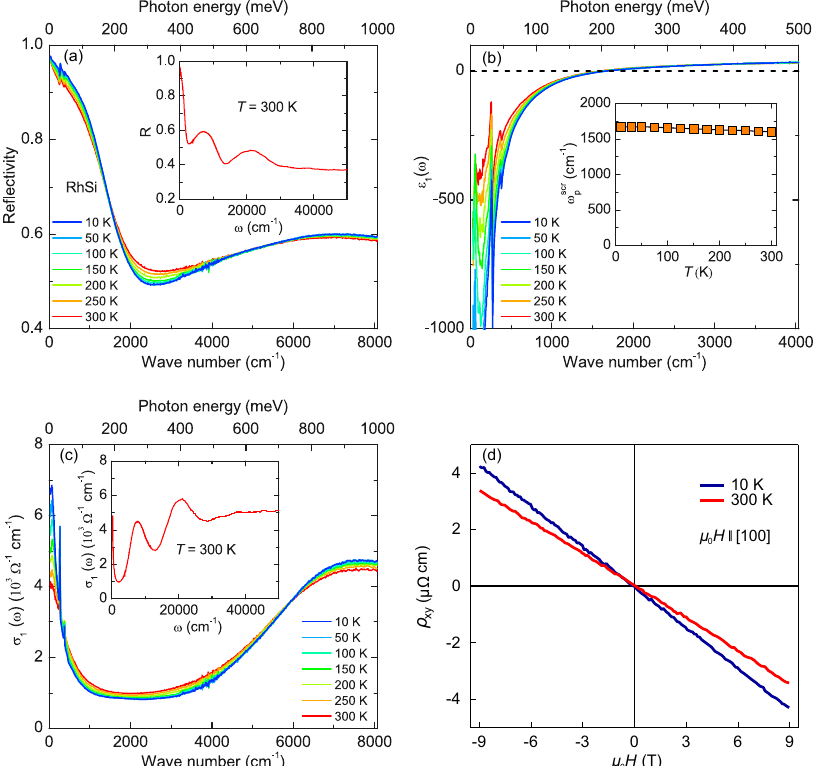
Fig. 1 Optical conductivity and Hall resistivity of RhSi. a Temperature dependence of the re fl ectivity spectra up to 8000 cm − 1 of RhSi. Inset shows the room temperature spectrum up to 50,000 cm − 1 . b Temperature dependence of the real part of the dielectric function ε 1 ( ω ). Inset shows screened plasma frequency of free carriers obtained from the zero crossings of ε 1 ( ω ). c Optical conductivity of RhSi up to 8000 cm − 1 at different temperatures. Inset: Optical conductivity shown up to 50,000 cm − 1 at room temperature. d Hall resistivity of RhSi at 10 and 300